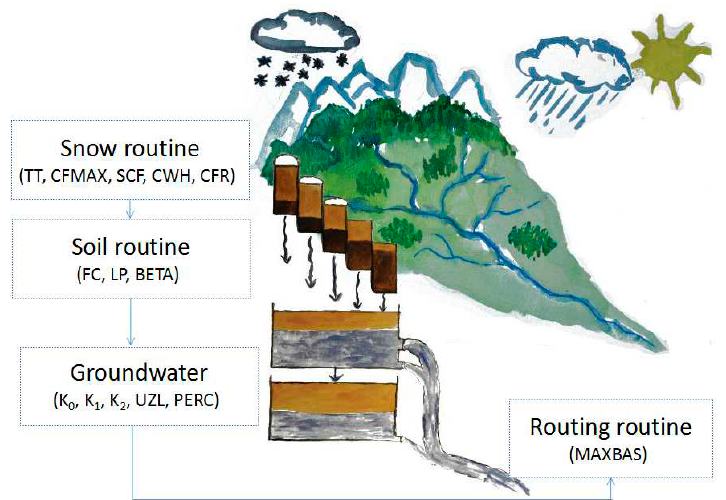
Figure 3. Schematic structure of the HBV (Hydrologiska ByransVattenavdelning) model, version HBV light model (used with permission from [22], originally painted by Petra